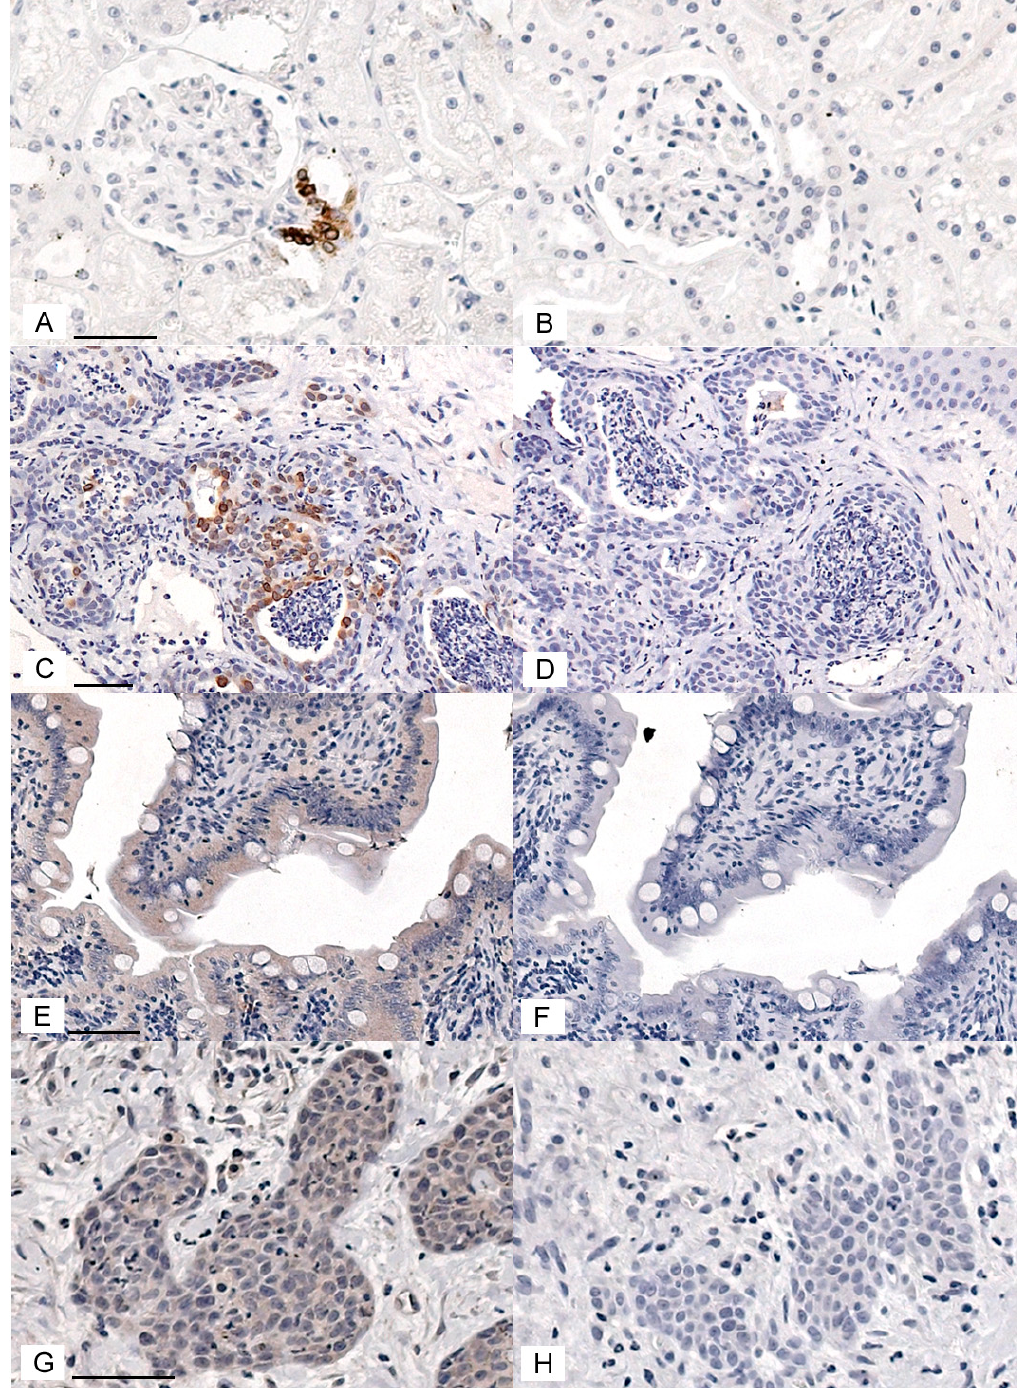
Figure 1. COX-2 and CD147 positive and negative controls for immunohistochemistry. ( A – D ) Photomicrographs of IHC staining using rabbit anti-COX-2 IgG (1:200) and normal rabbit IgG (1:200, negative control). The chromogen is DAB (brown), and the counterstain is hematoxylin (blue). The feline renal macula densa epithelial cells had an intense cytoplasmic signal ( A ) that was eliminated